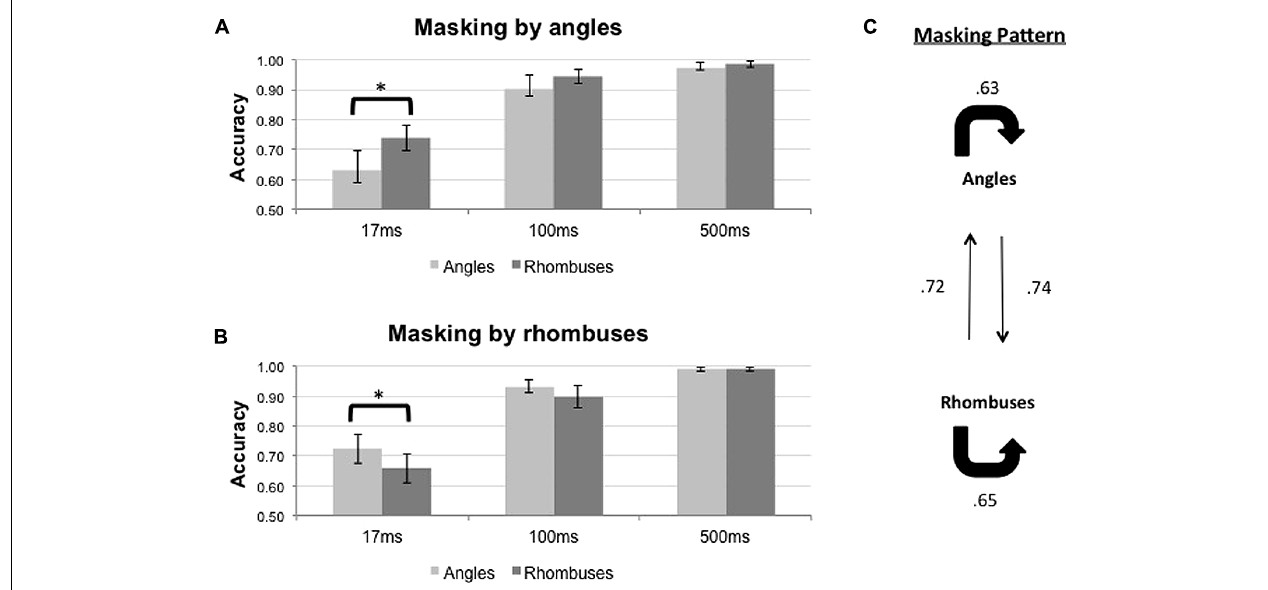
bars denote standard errors of means. Asterisks denote statistically significant difference between conditions as shown by paired samples t- test. (C) Masking pattern between angles and rhombuses. The accuracy of target identification was indicated by the numbers next to the arrows.